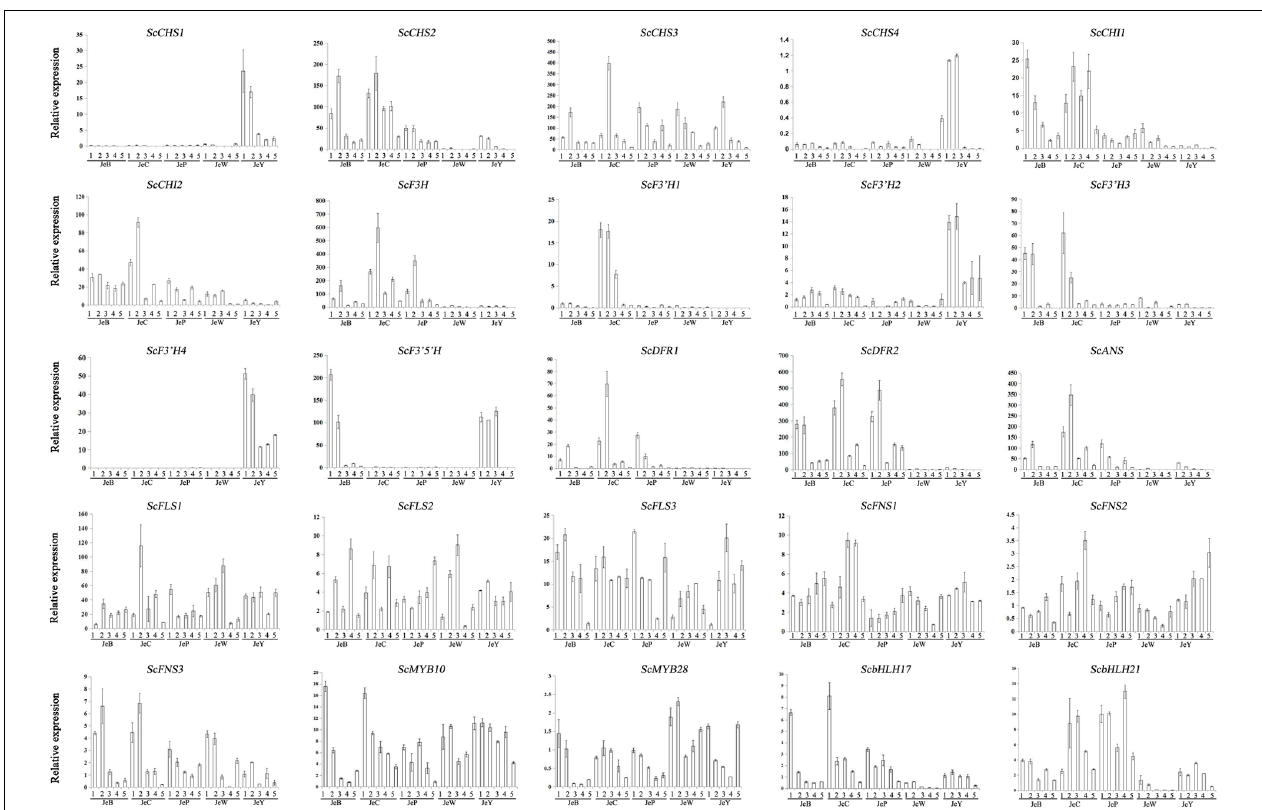
FIGURE 4 | Real-time quantitative reverse transcription-PCR (qRT-PCR) of ABP genes in S. cruentus